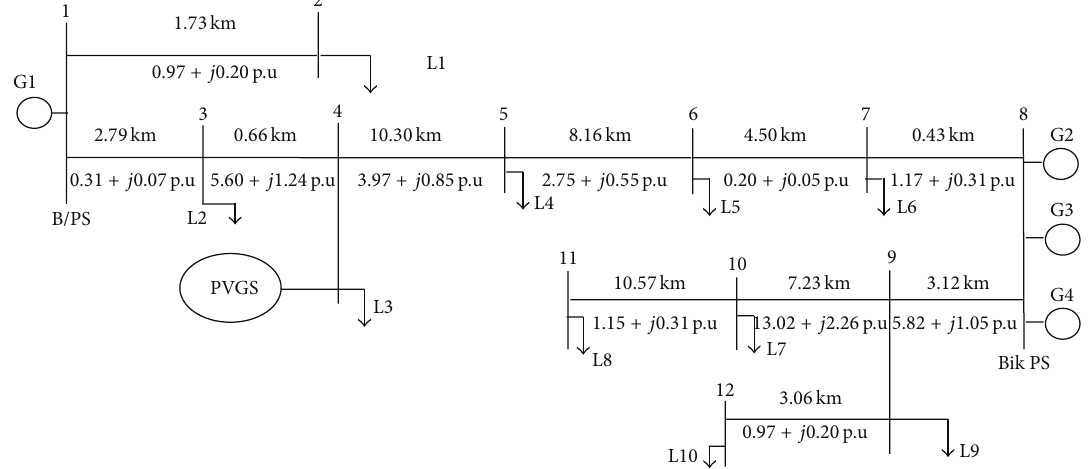
Figure 2: One-line diagram of the study of PUB DNST